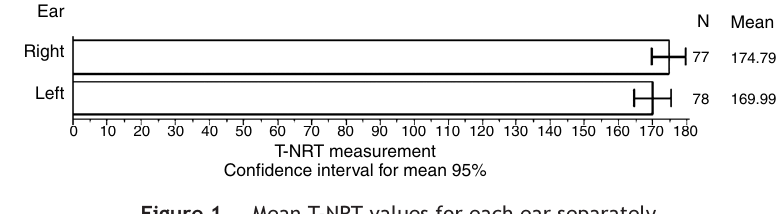
Figure 1 Mean T-NRT values for each ear separately.